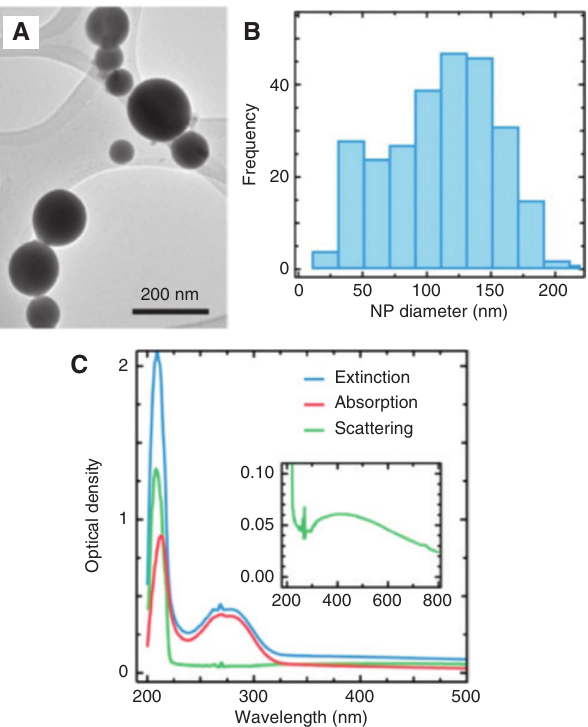
Figure 9: Plasmonic properties of liquid-metal nanoparticles. (A) Transmission electron microscopy image and (B) size distribution of EGaIn liquid-metal nanoparticles suspended in ethanol. (C) Experimental extinction, absorption and scattering spectra showing the plasmon resonances at ~ 215 nm and ~ 270 nm. Inset: scattering spectrum in a wider wavelength range. Reprinted from